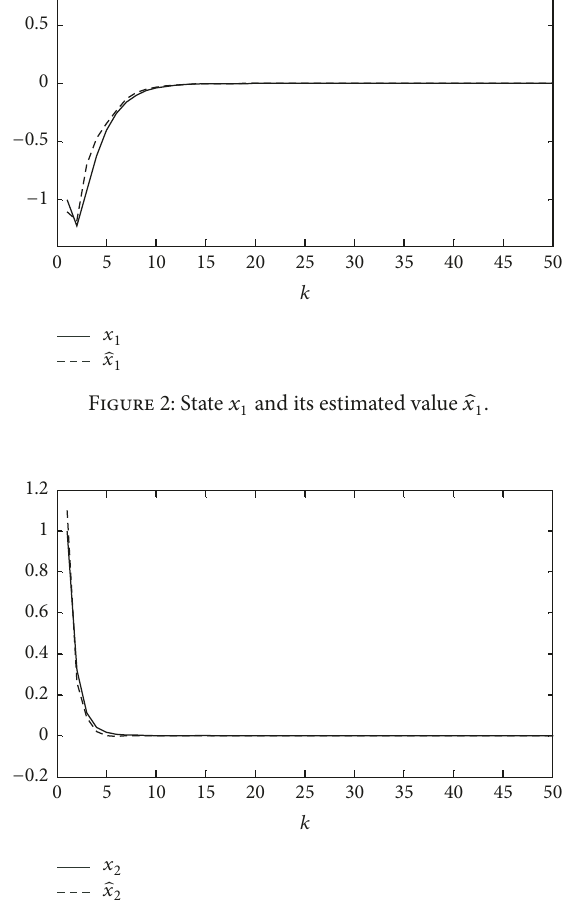
Figure 3: State 𝑥 2 and its estimated value ̂𝑥 2 .